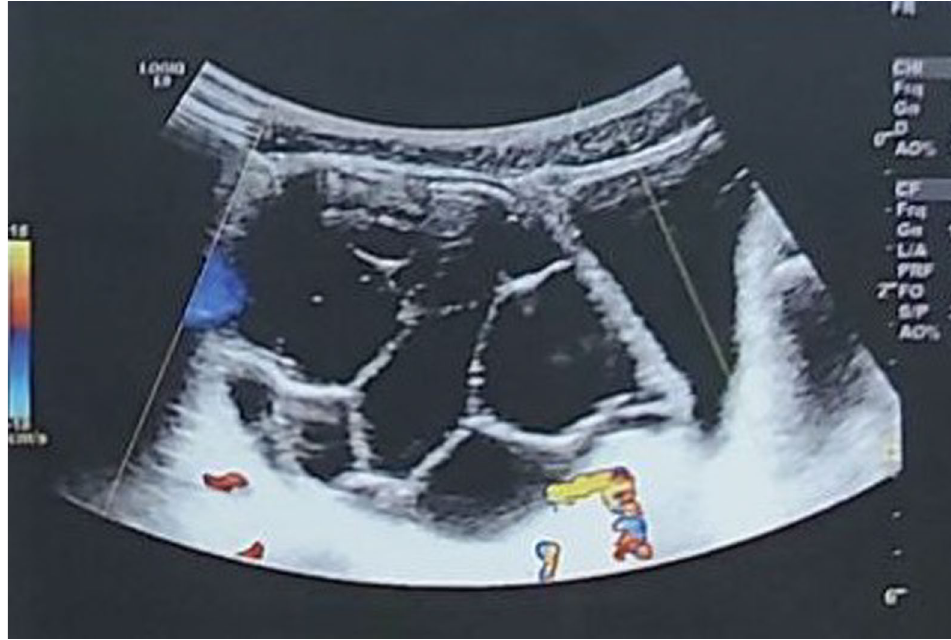
Fig. 1 A large cystic mass with heterogeneous echogenicity is supra bladder located with multiple septa